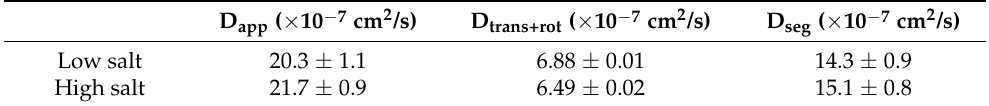
Figure 7. Summary of the analysis of the QENS spectra of α Syn. ( a ) Summary of Q 2 -dependence of the Γ values. Symbols in black and red are those for the high- and low-salt conditions, respectively. ( b ) Summary of Q 2 -dependence of Γ local . ( c ) Summary of the diffusion coefficients, D app , D trans+rot , and D seg , obtained from linear fits to the plots in ( a ). ( d ) Summary of D jump . ( e ) Summary of the residence time, τ . D jump and τ are obtained from the fits with the equation based on the jump-diffusion model to the plots in ( b ). ( f ) The EISF curves and the results of the fits. Solid lines represent the results of the analysis using Equation (6), and dashed lines represent the results of the analysis based on the diffusion-inside-a-sphere model employed in the previous study [14]. ( g ) A summary of the fraction of the “immobile” atoms. Bars represent the results of the analysis using Equation (6). Open circles represent the results of the analysis based on the diffusion-inside-a-sphere model. ( h ) The radial distributions of the fraction of the “mobile” atoms. Solid lines represent the results of the analysis using Equation (6). Bars represent the results of the analysis based on the diffusion-inside-a-sphere model. Error bars within the symbols are not shown. Table 3. Summary of the diffusion coefficients of α